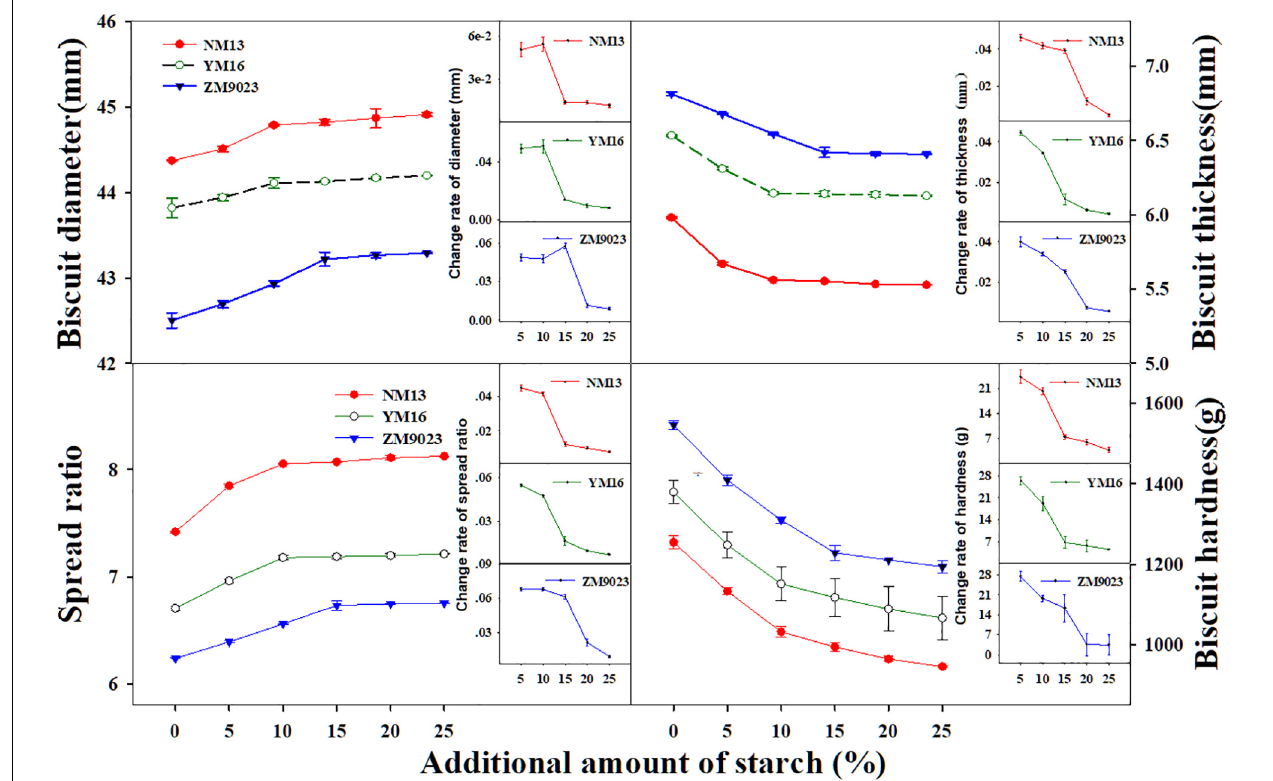
FIGURE 2 | Effect of the addition amount of starch on diameter, thickness, spread ratio, and hardness of short biscuits. NM13, YM16, and ZM9023 indicate Ningmai 13, Yangmai 16 and Zhengmai 9023, respectively. Small figures in the corner of big Figs are rate of change of biscuit traits.